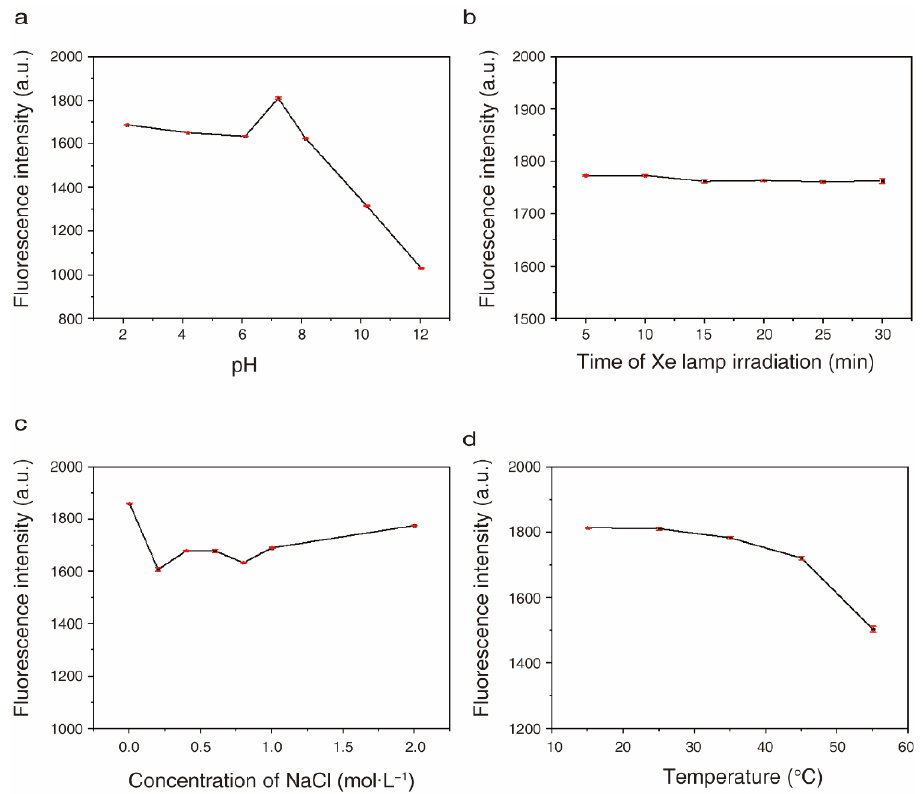
Figure 5. Fluorescence stability of CQDs prepared from chicken bones. The fluorescence intensity of CQD solutions was measured under the indicated ( a ) pH, ( b ) NaCl concentration, ( c ) temperature and ( d ) Xe lamp irradiation (5–30 min) conditions.